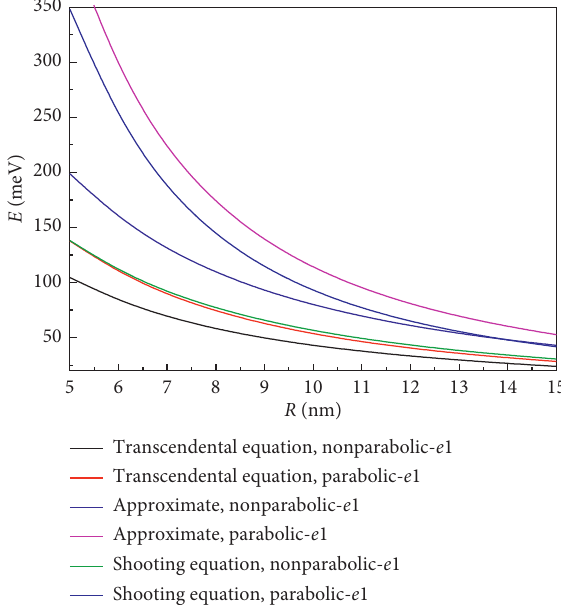
Figure 2: The dependence of energy on the radius of a cylindrical nanowire for electrons and holes with the parabolic and non- parabolic dispersion